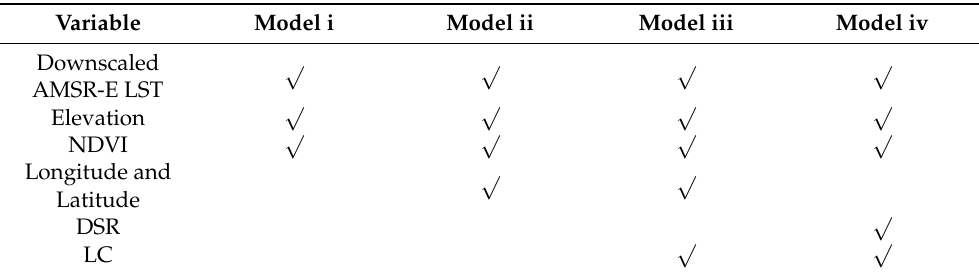
Table 3. Variable selection status of candidate RF models.